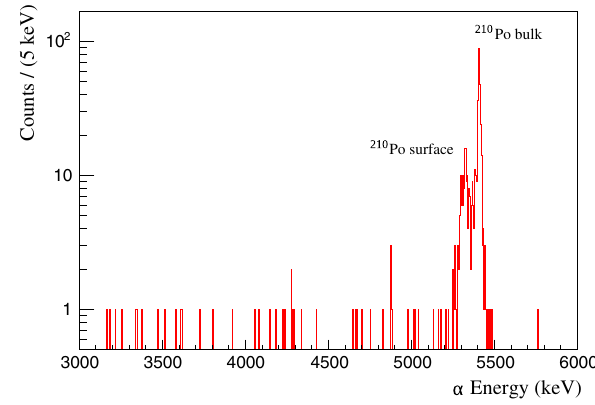
Fig. 16 Summed background spectrum using 11.1 days of data from 19/20 Li 2100 MoO 4 cryogenic detectors of the CUPID-Mo experiment